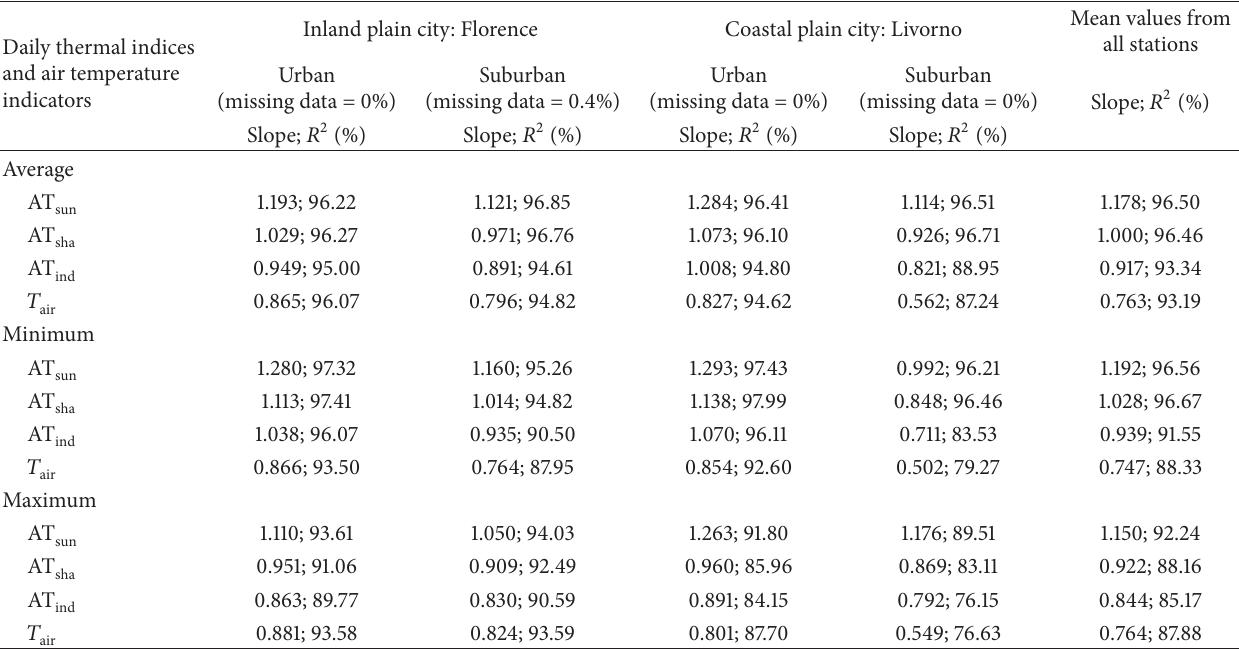
Table 3: Correlation analyses between daily average, minimum, and maximum UTCI versus direct thermal indices and air temperature indicators in urban and suburban areas of Florence and Livorno during the warmest period of the year (May–October) from 2006 to